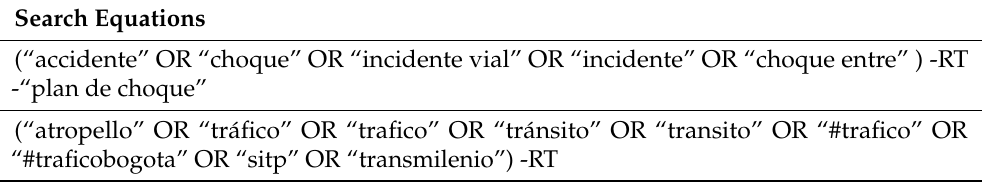
Table 2. Search equations defined for tweets in Spanish and